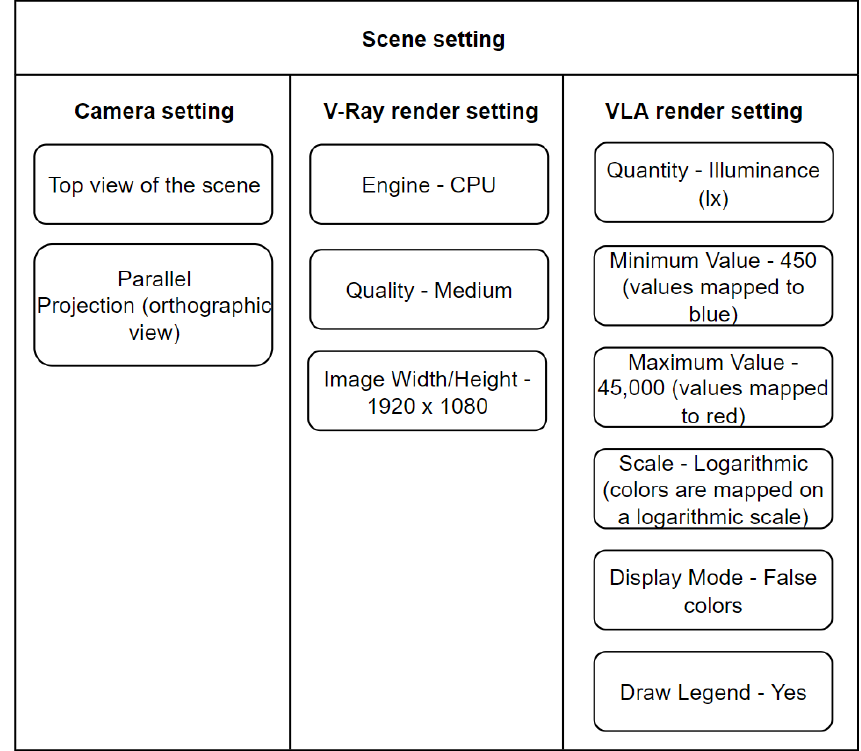
Figure 9. Scene settings for correct heat map rendering.